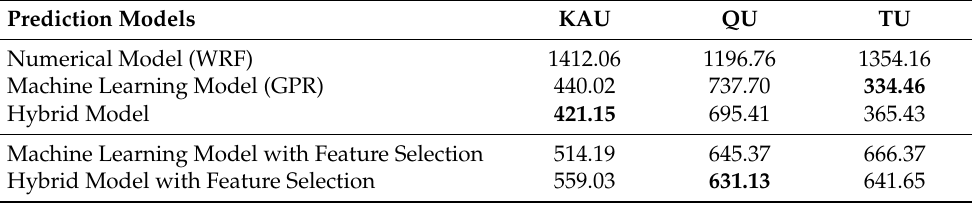
Table 10. RMSE of GHI values (in W/m 2 ) using different regression prediction models on dust storm